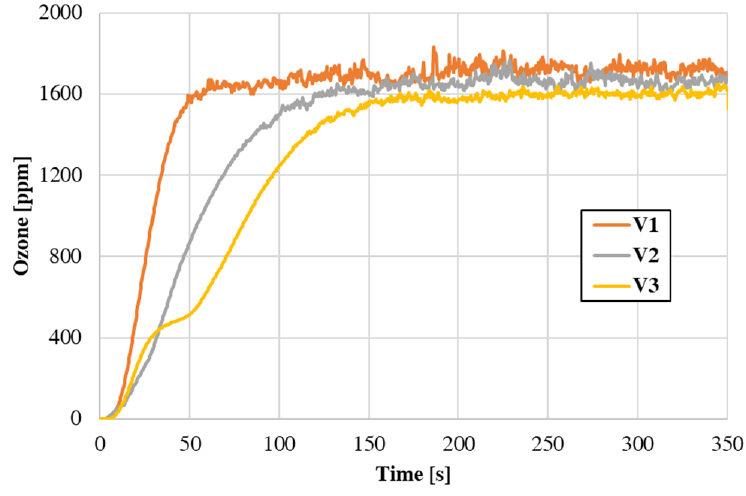
Figure 4. O 3 concentration kinetics for different treatment volumes (V1, V2, V3). The time needed in the different cases to overcome the threshold of 1600 ppm ozone concentration, and the maximum concentration reached during treatments, are reported in Table 3. Table 3. Time needed to overcome the threshold of 1600 ppm of ozone concentration for different treatment volumes and maximum O 3 concentration reached during treatment.